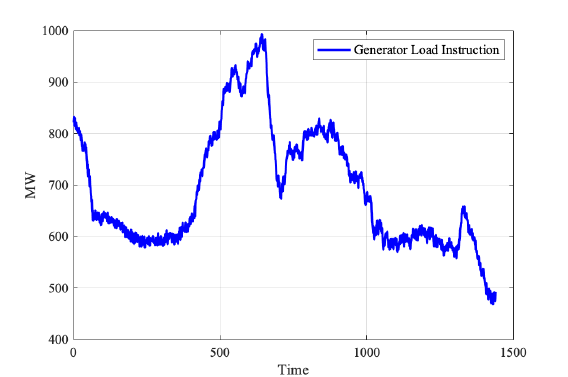
Figure 2. Schematic of the generator load